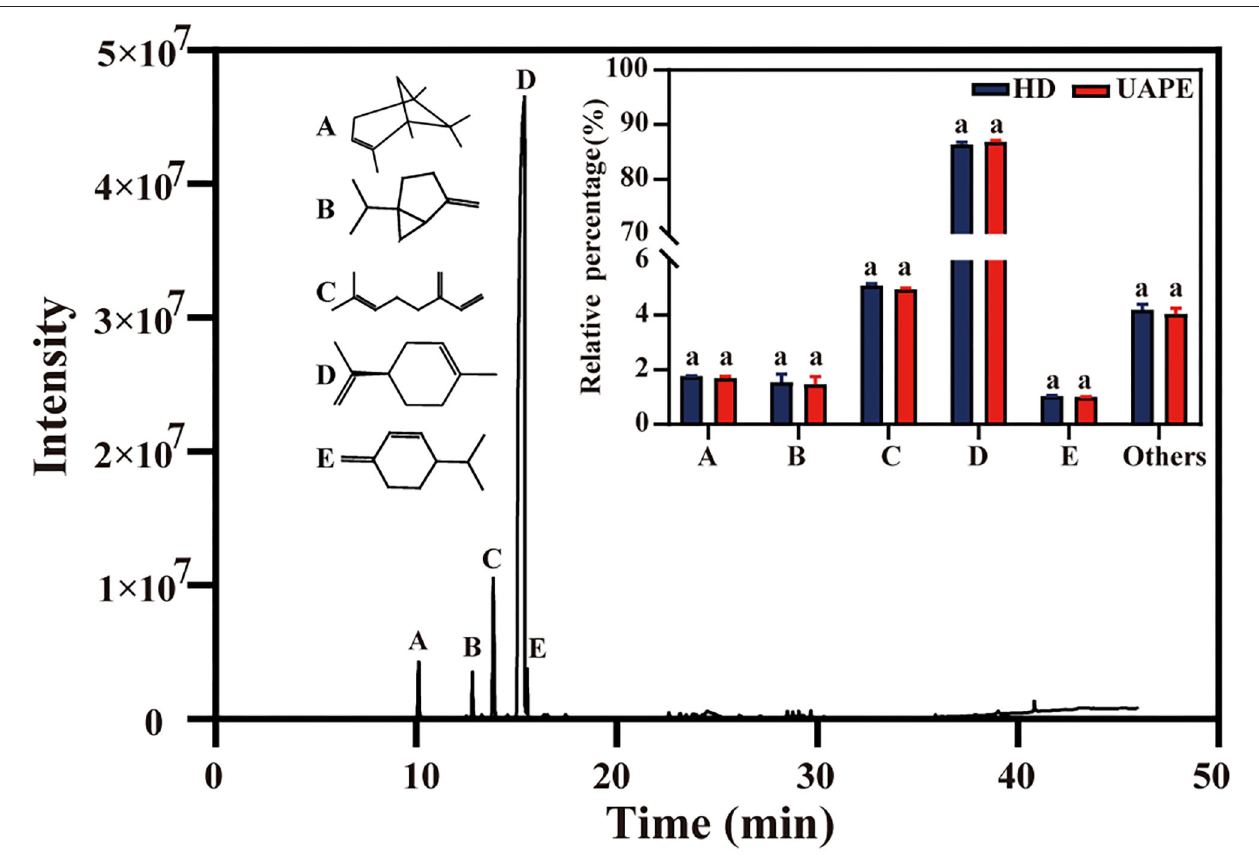
FIGURE 7 | Total ion chromatogram of HD and UAPE. Inset: chemical structural formulas of five main compounds ( α -pinene, sabinene, β -myrcene, D -limonene, β -phellandrene) and their relative percentage in the essential oils extracted by two methods. For each compound, values with the same latter are not significantly at the p < 0.05 level according to